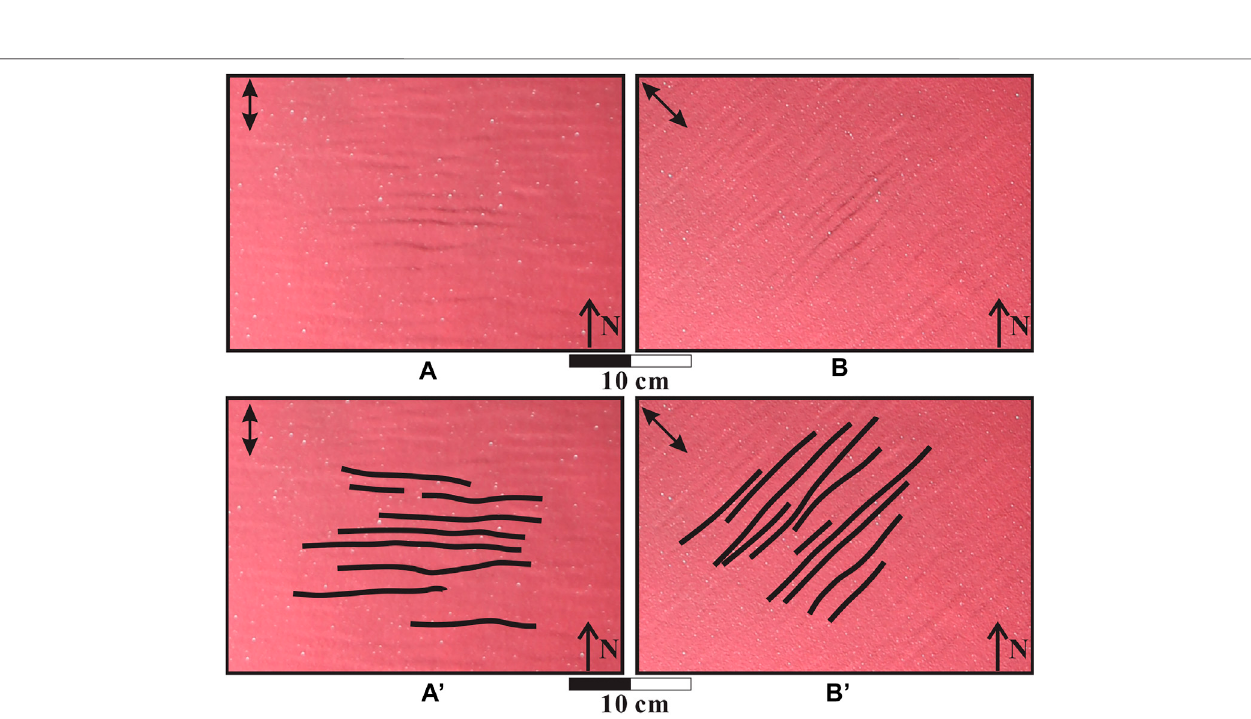
FIGURE12| ModelingresultsofSeriesIexperiments. (A) AseriesofE-W-strikingfaultsareformedunderaN-Sstressdirection,indicatedbytheblacklinesin (A ’ ) . (B) A series of NE-SW-striking faults are formed under a NW-SE stress direction, indicated by the black lines in (B ’ ) .